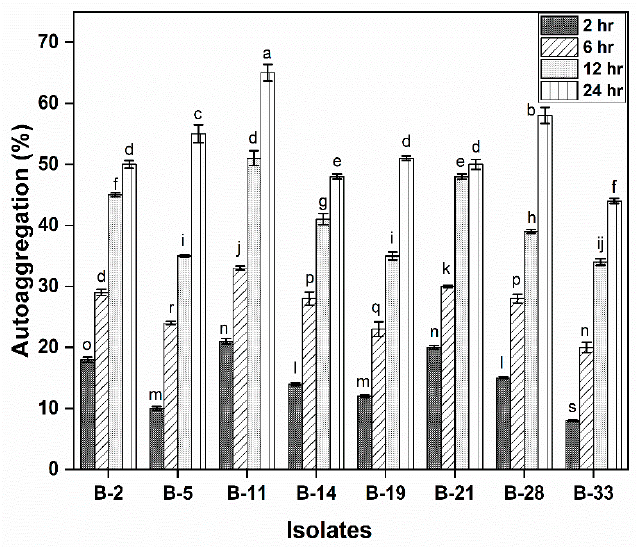
Figure 2. Autoaggregation (%) of isolates is calculated after 2 h, 6 h, 12 h and 24 h of incubation. Each value represents the mean value ± standard deviation (SD) ( n = 3). Bars with different lower-case letters denoted significantly different ( p < 0.05).